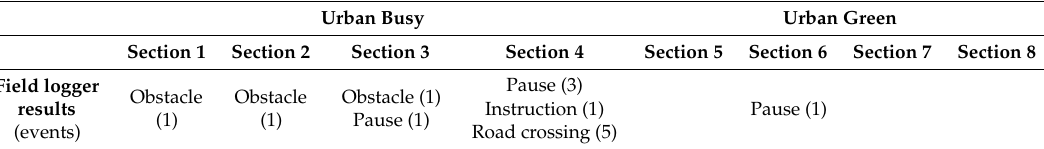
Table 3. Description of events occurring across the walks during the urban busy to urban green